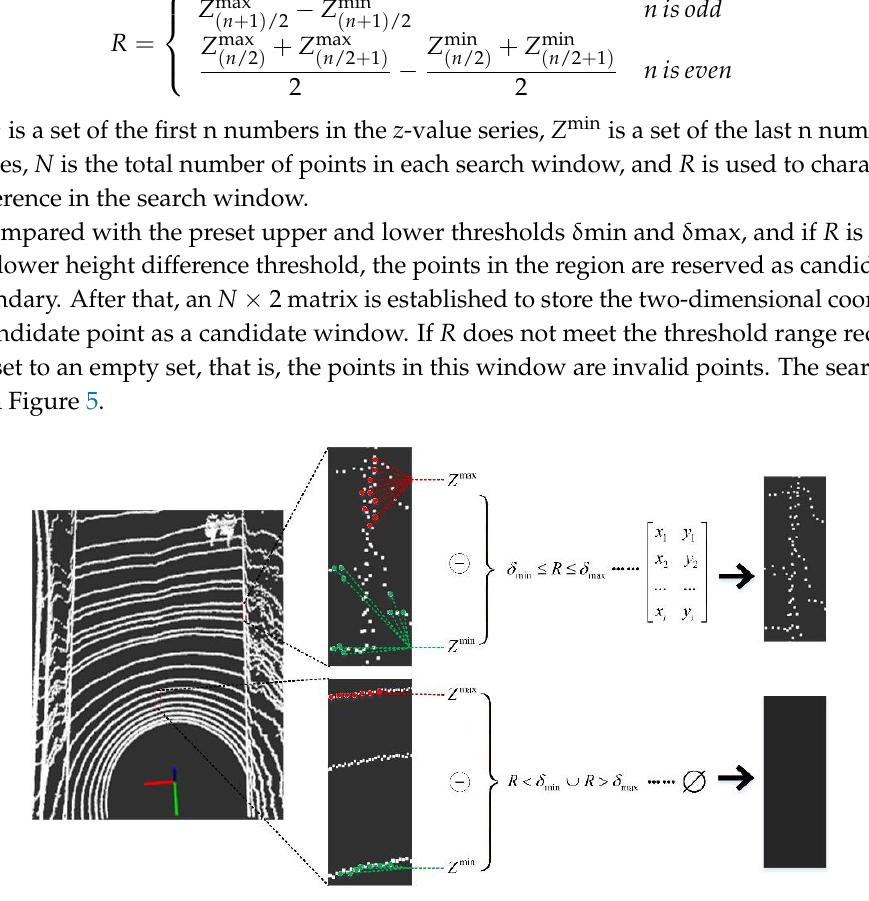
Figure 5. Schematic of the first search window. In this search, we propose the concept of the largest cluster point set ( Z max ) and the smallest cluster point set ( Z min ).